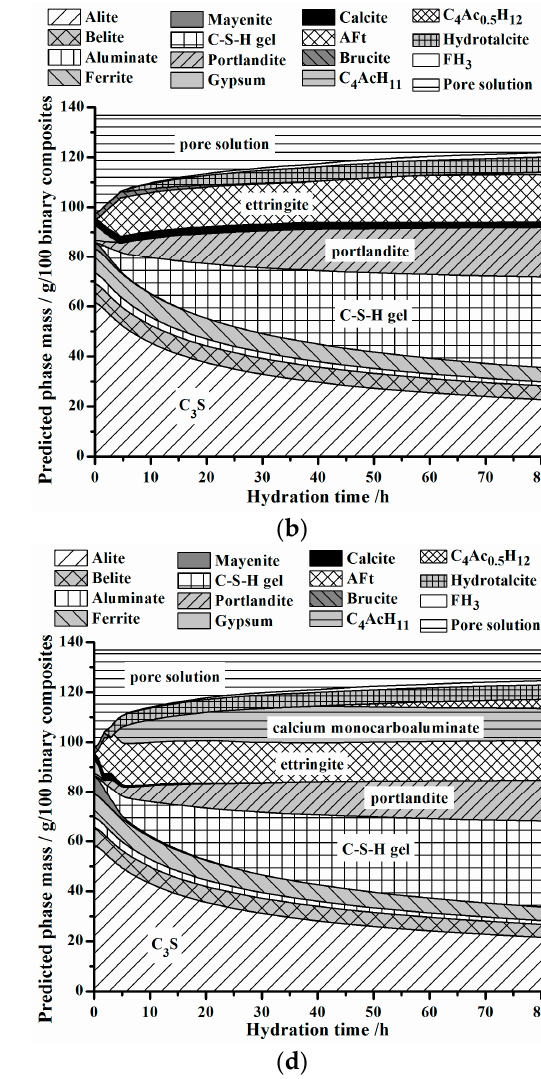
Figure 7. Predicted hydrate assemblages at different hydration ages with w/c = 0.4 at 20 °C. ( a ) M0; ( b ) M2; ( c ) M5; ( d ) M7.